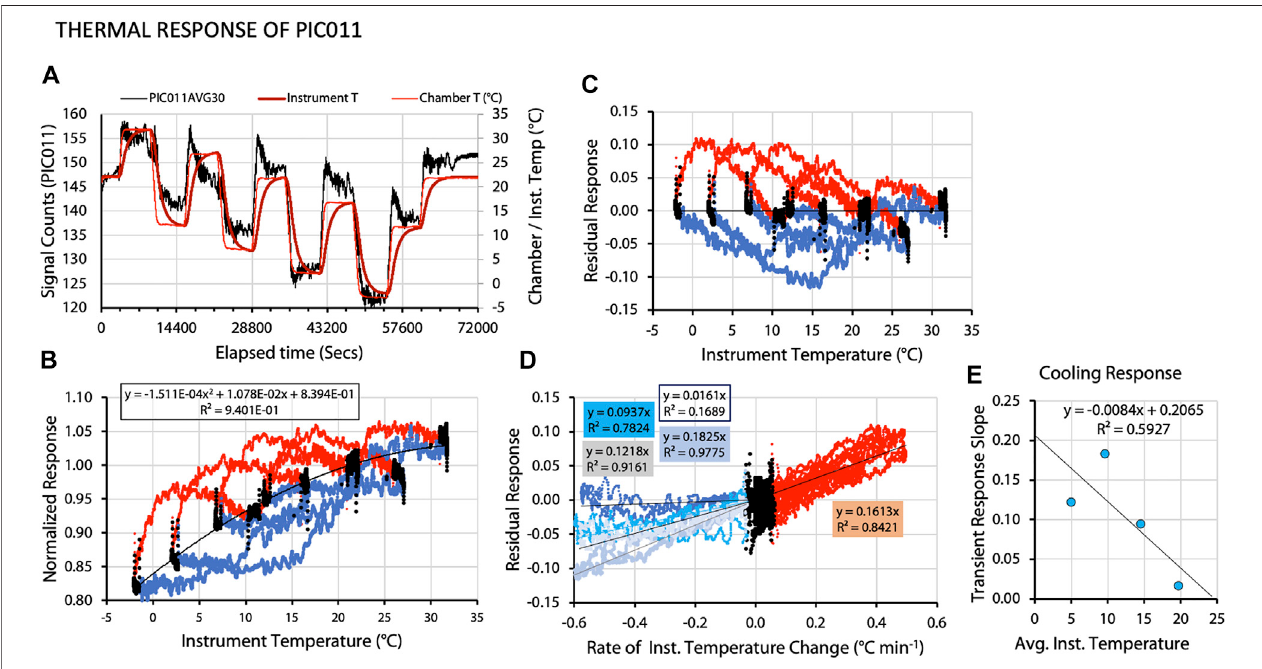
FIGURE 5 | Thermal cycling response of sensor PIC011. Figure elements (A – E) are the same as described in Figure 4 .